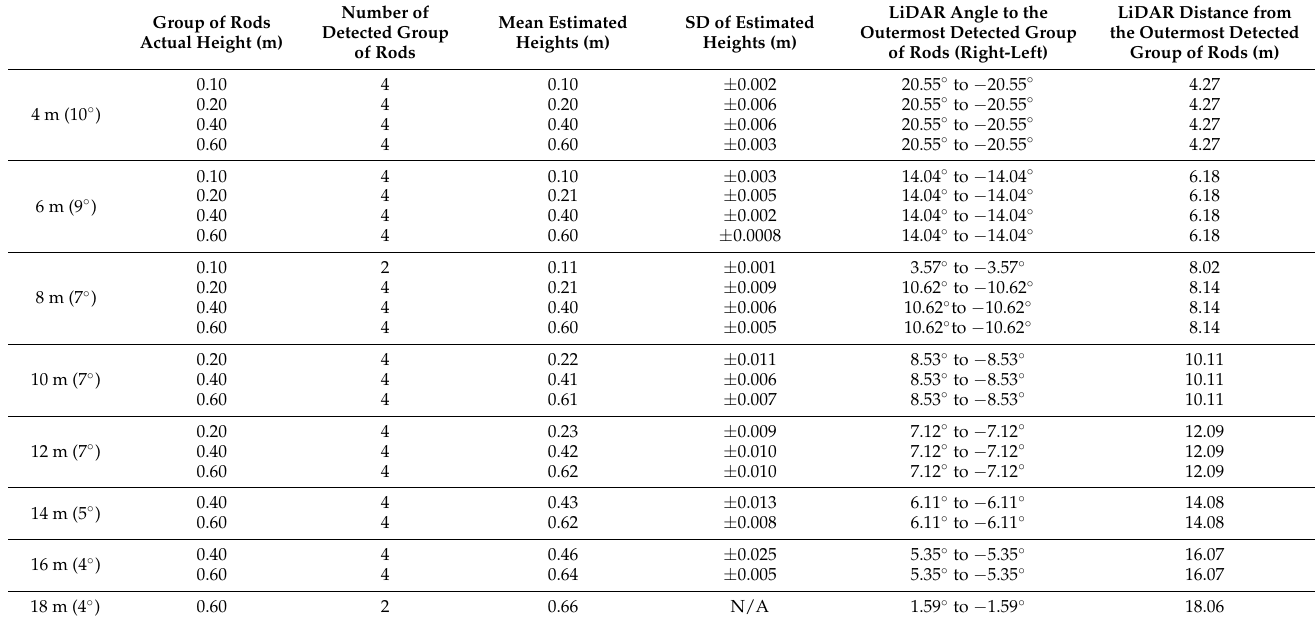
Table 3. Effect of LiDAR distance on detectability and height estimation of a perpendicular line of four groups of rods. The LiDAR was 0.70 m above the ground. The LiDAR distance from the middle of the line of rods groups was 4, 6, 8, 10, 12, 14, 16, 18 m and the LiDAR vertical angle was 10 ◦ , 9 ◦ , 7 ◦ , 7 ◦ , 7 ◦ , 5 ◦ , 4 ◦ , 4 ◦ , respectively. Number of Group of Rods Detected Actual Height (m)